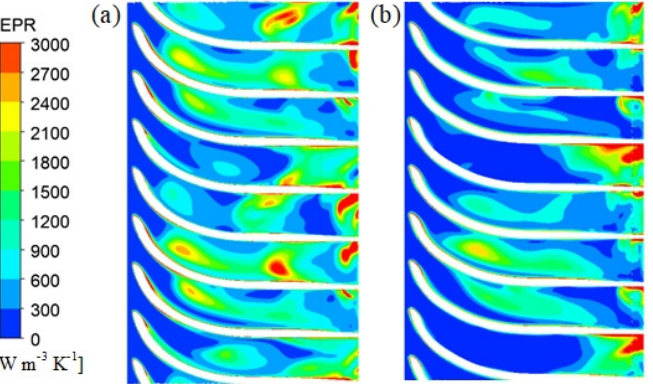
Figure 15. Distribution of local entropy production in the axial cascades: ( a ) original scheme and ( b ) optimization scheme.